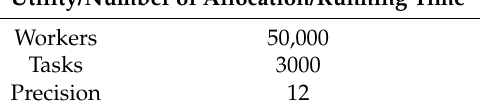
Table 7. Experimental settings for Yelp real